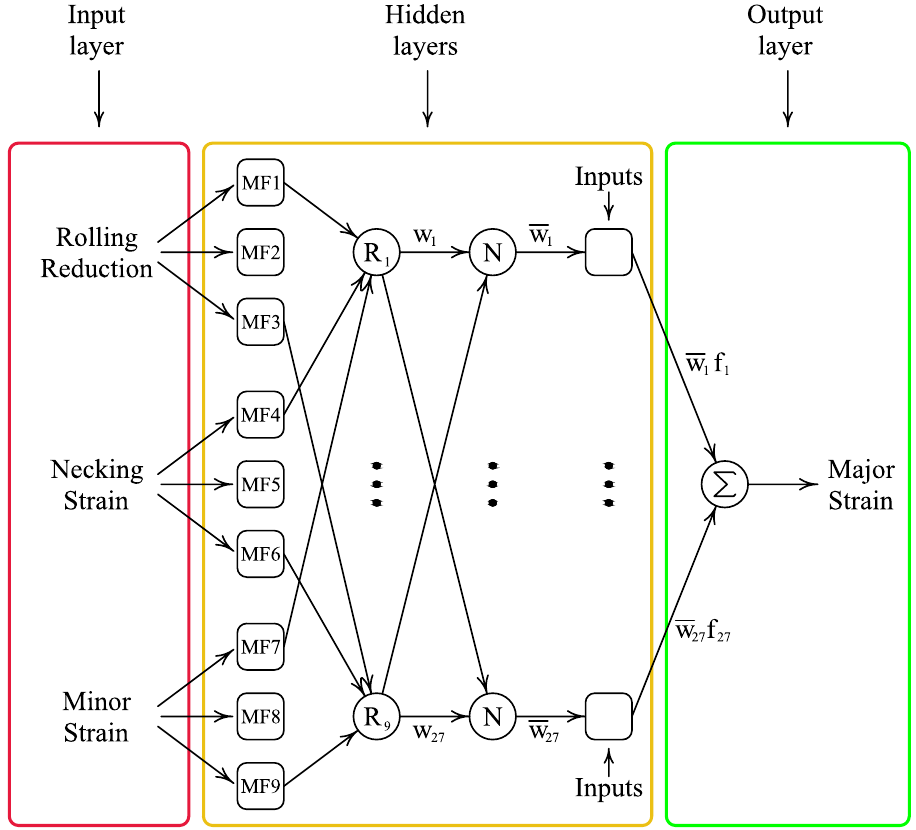
Figure 8. Schematic of ANFIS layers for three inputs and one outputs.